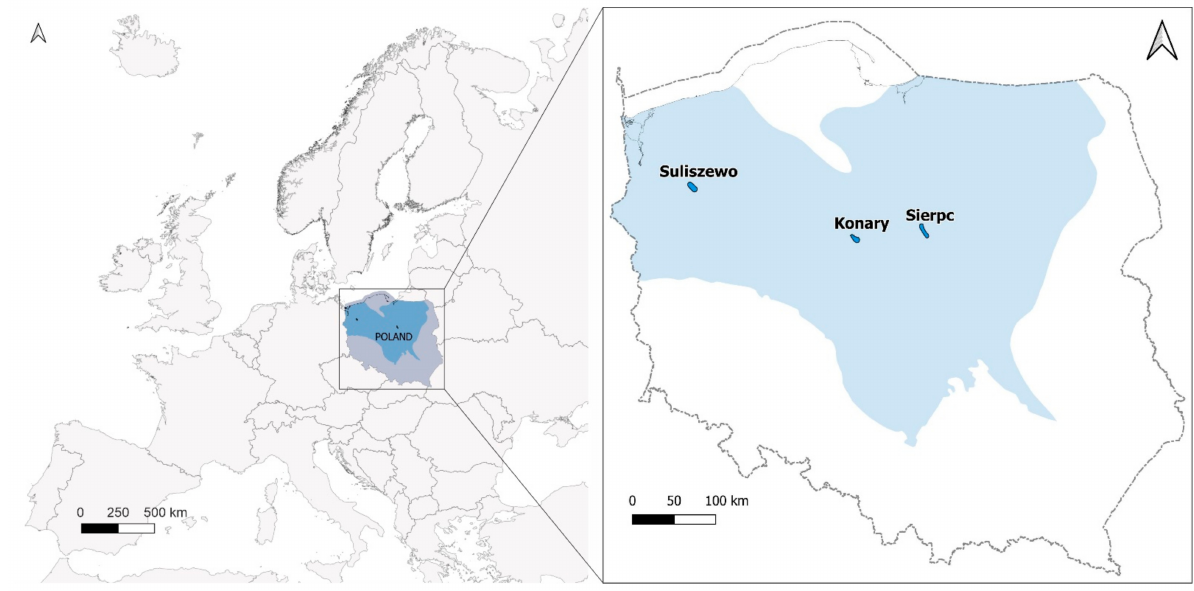
Figure 1. Location of the structures: Konary, Sierpc, and Suliszewo in Poland and Europe against the background of the Lower Jurassic